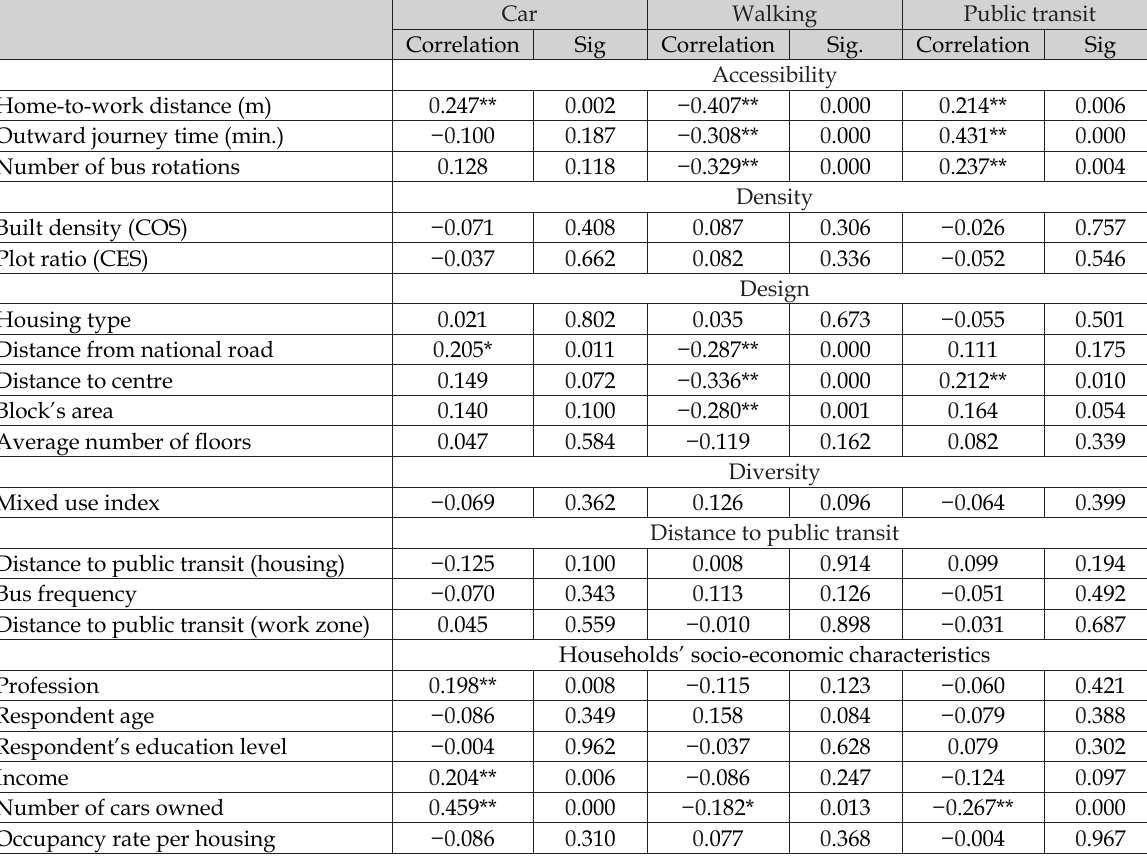
Table 3. Results of Pearson’s bivariate correlation.